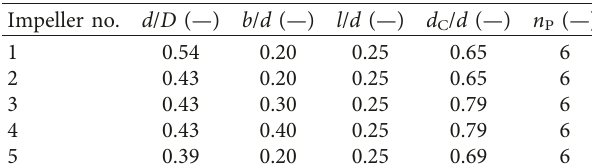
Figure 1: Experimental equipment. (a) Mixing vessel. (b) Turbine impeller. (c) Schematic illustration of PIV experiment. Table 1: Specifications of the impellers.